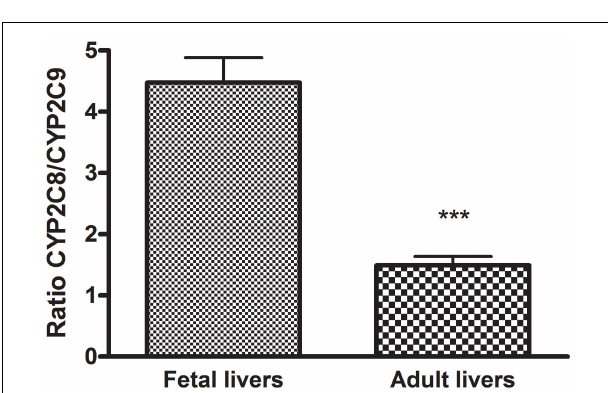
FIGURE 2 |The ratio of the mRNA expression of CYP2C8 compared to CYP2C9 in fetal and adult liver. The ratio between CYP2C8 and CYP2C9 was calculated to 4.5 in fetus and 1.5 in adult demonstrating three times higher expression of CYP2C8 compared to CYP2C9 in fetus than in adult. *** p < 0.001.